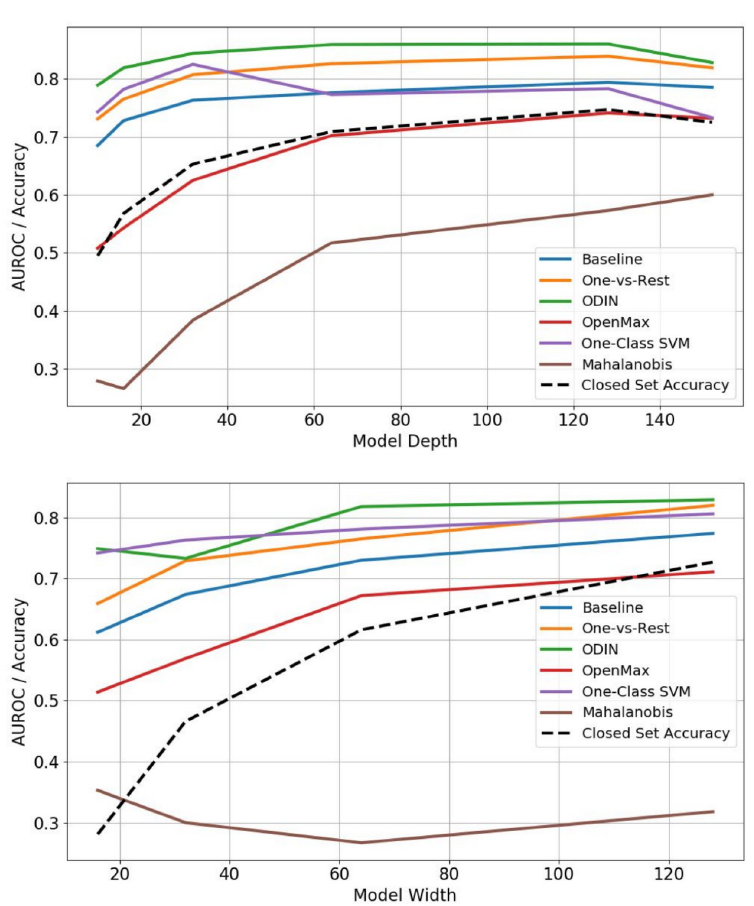
Fig 7. OOD detection performance versus model capacity. A ResNet architecture was varied in either depth or width and trained on the ImageNet-500 split and then tested for detecting image classes unseen during training via the remaining ImageNet categories (Intra-dataset). Overall improvements in performance as reflected in the AUROC of the model track improvements in model accuracy as model capacity increases.